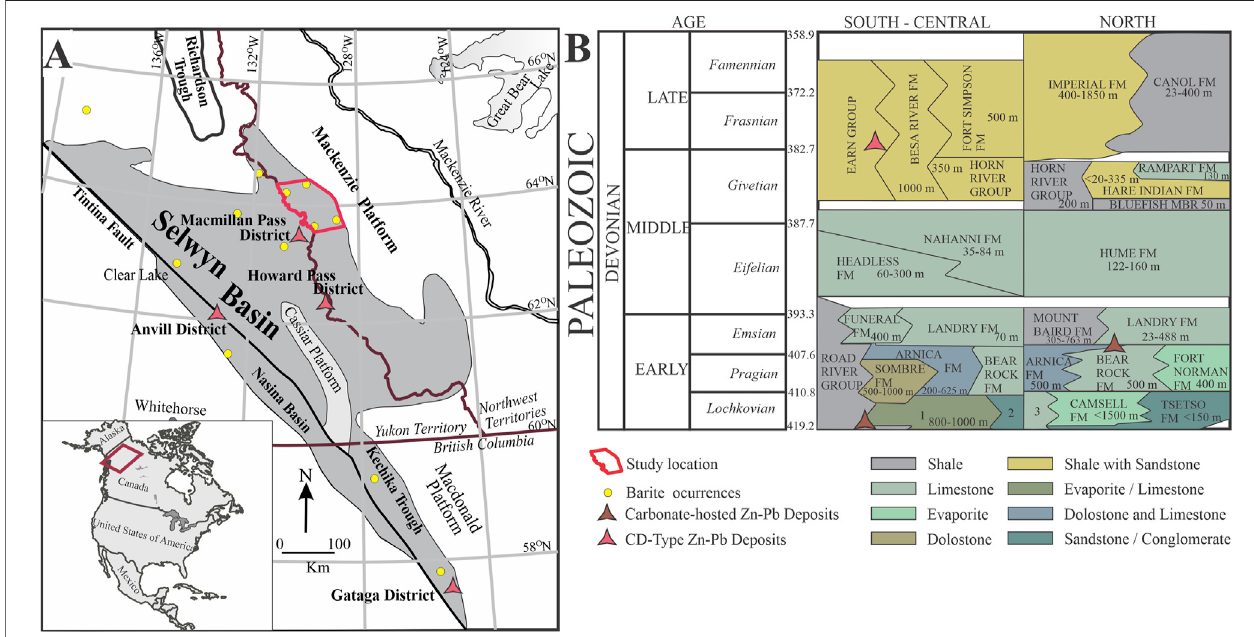
FIGURE1| RegionalgeologyandstratigraphyoftheSelwynBasinwithintheNorthAmericancontinent. (A) Simpli fi edgeologicmapofPaleozoicsedimentaryunits in the Selwyn Basin bounded by the Tintina Fault in the west and the Mackenzie carbonate platform in the east (modi fi ed from Goodfellow & Lydon, 2007). Major barite and clastic-dominated (CD-type) Zn-Pb deposits are indicatedby the yellow cycle and red triangle, respectively. The red area in B depicts the current study location. (B) Devonian stratigraphic sequence of the Selwyn Basin from south to north (modi fi ed from Martel et al., 2011; Ootes et al., 2013; Morrow, 2018). 1 (cid:1) Camsel — Cadillac Delorme Formation. 2 (cid:1) Tsetso Formation. 3 (cid:1) Unnamed